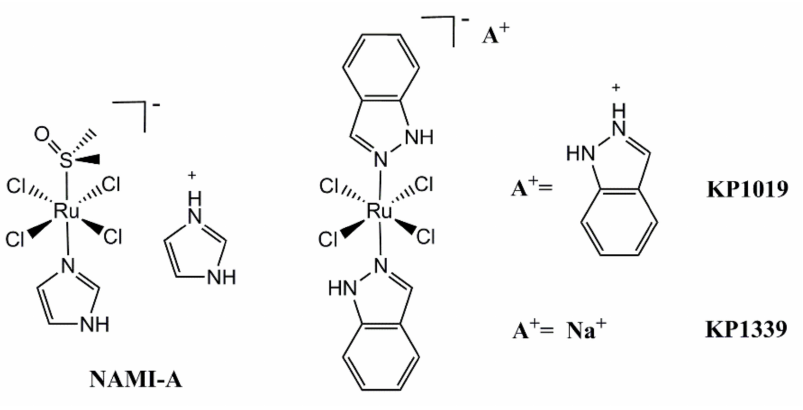
Figure 2. Three ruthenium(III) complexes in clinical